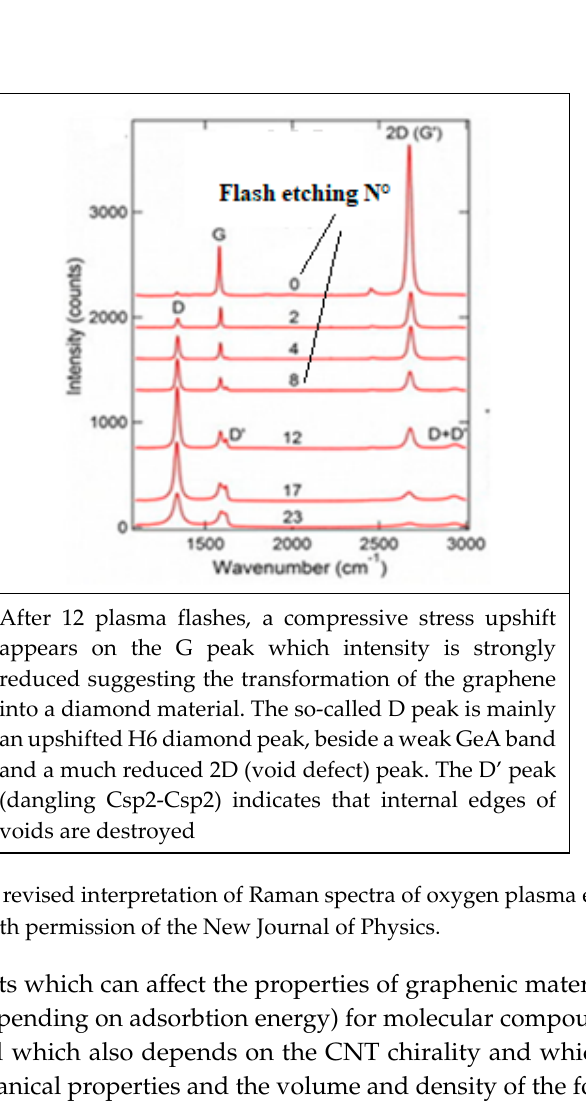
Figure 18. Example of revised interpretation of Raman spectra of oxygen plasma etched graphene by Childres et al. [237] with permission of the New Journal of Physics.